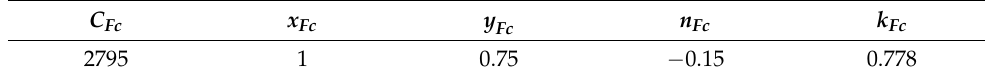
Table 3. Turning empirical model parameters.